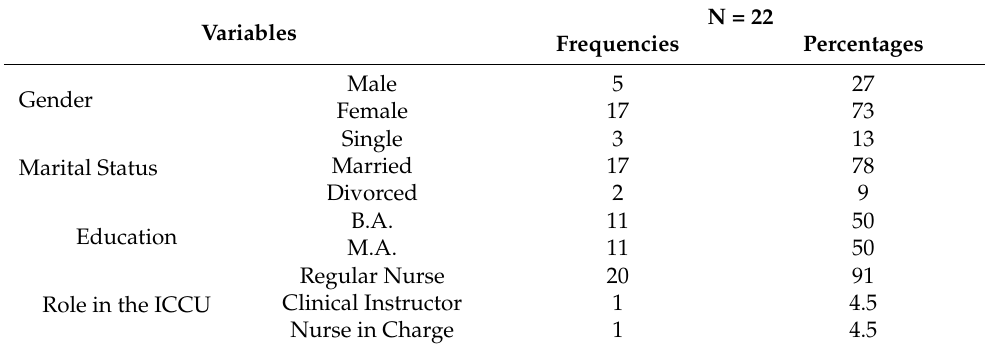
Table 1. Participants’ Background